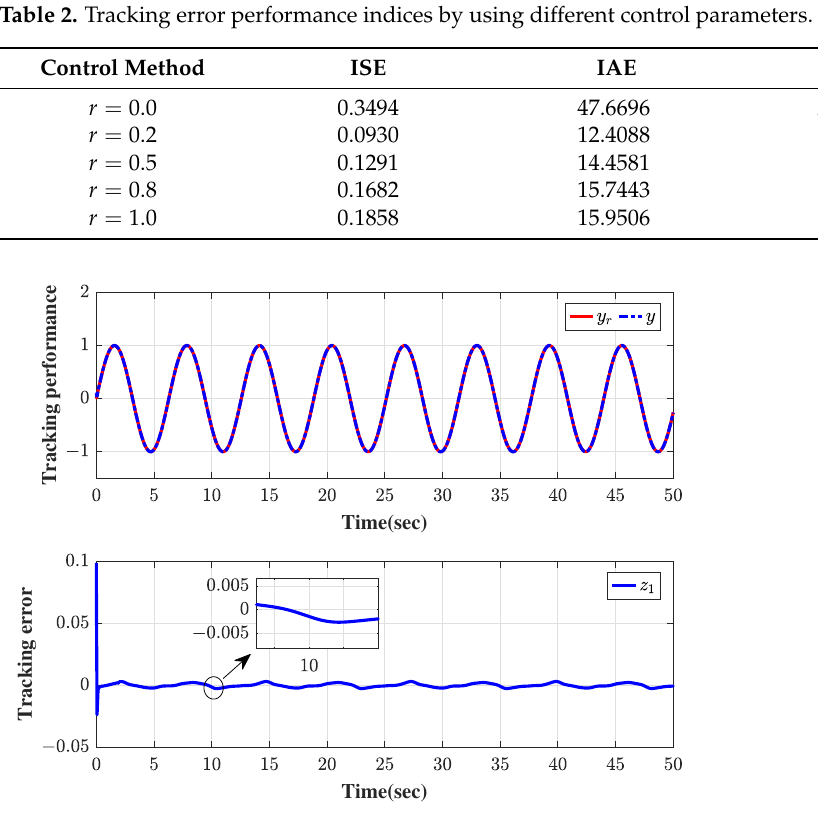
Figure 1. Tracking performance and tracking